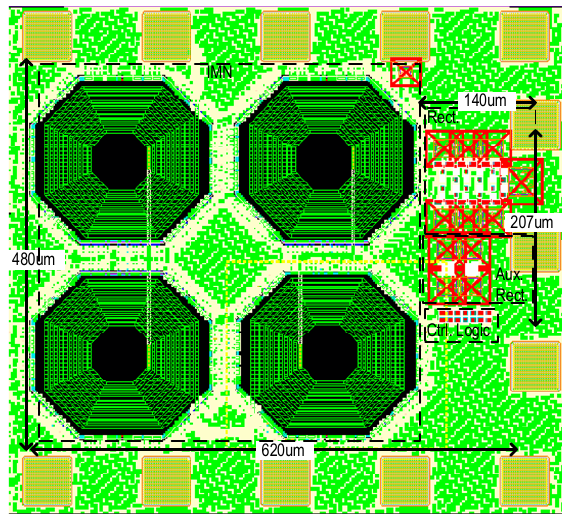
Figure 12. Chip layout of the proposed RFEH front end. Table 1. The proposed circuit’s components sizing.